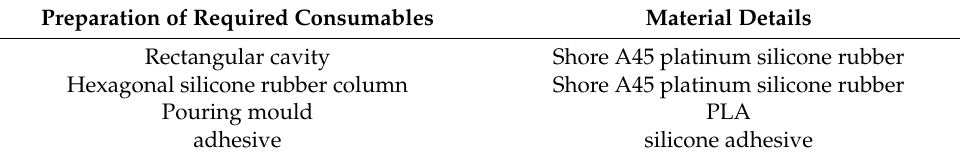
Table 3. Preparation of